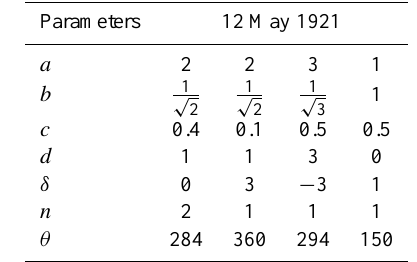
Table 1. The set of parameters of the four tori used to simulate the magnetogram of 12 May